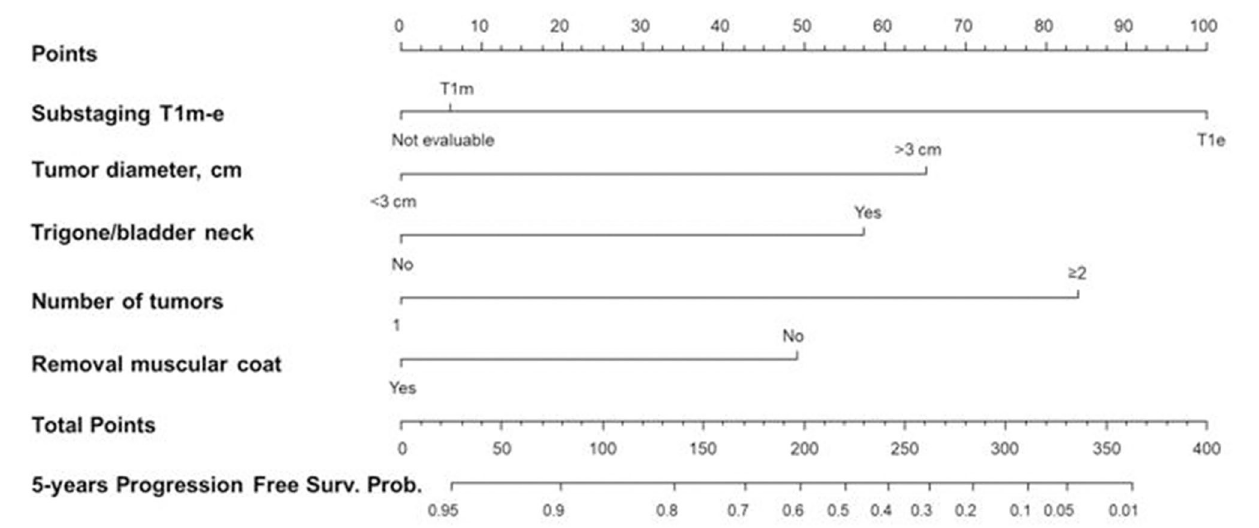
FIGURE 7 | Nomogram 2 for the calculation of the progression-free survival (PFS) at five years. On the basis of the estimated Cox regression model, a patient with T1e (100 points), > 3cm tumor diameter (65 points), trigone/bladder neck location of the tumor (57 points), number of tumors ≥ 2 (84 points), and with no presence of the muscle layer in the resected specimens (49 points) had a total score of 355 that corresponds to a low 5-year PFS probability ( p < 0.05).